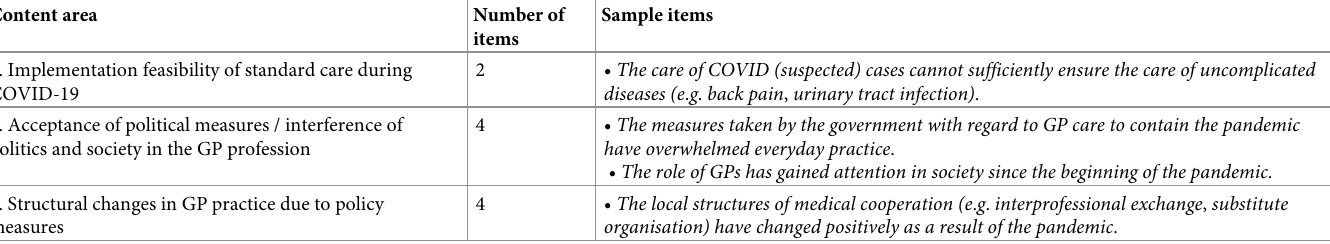
Table 2. Added questions for Germany a